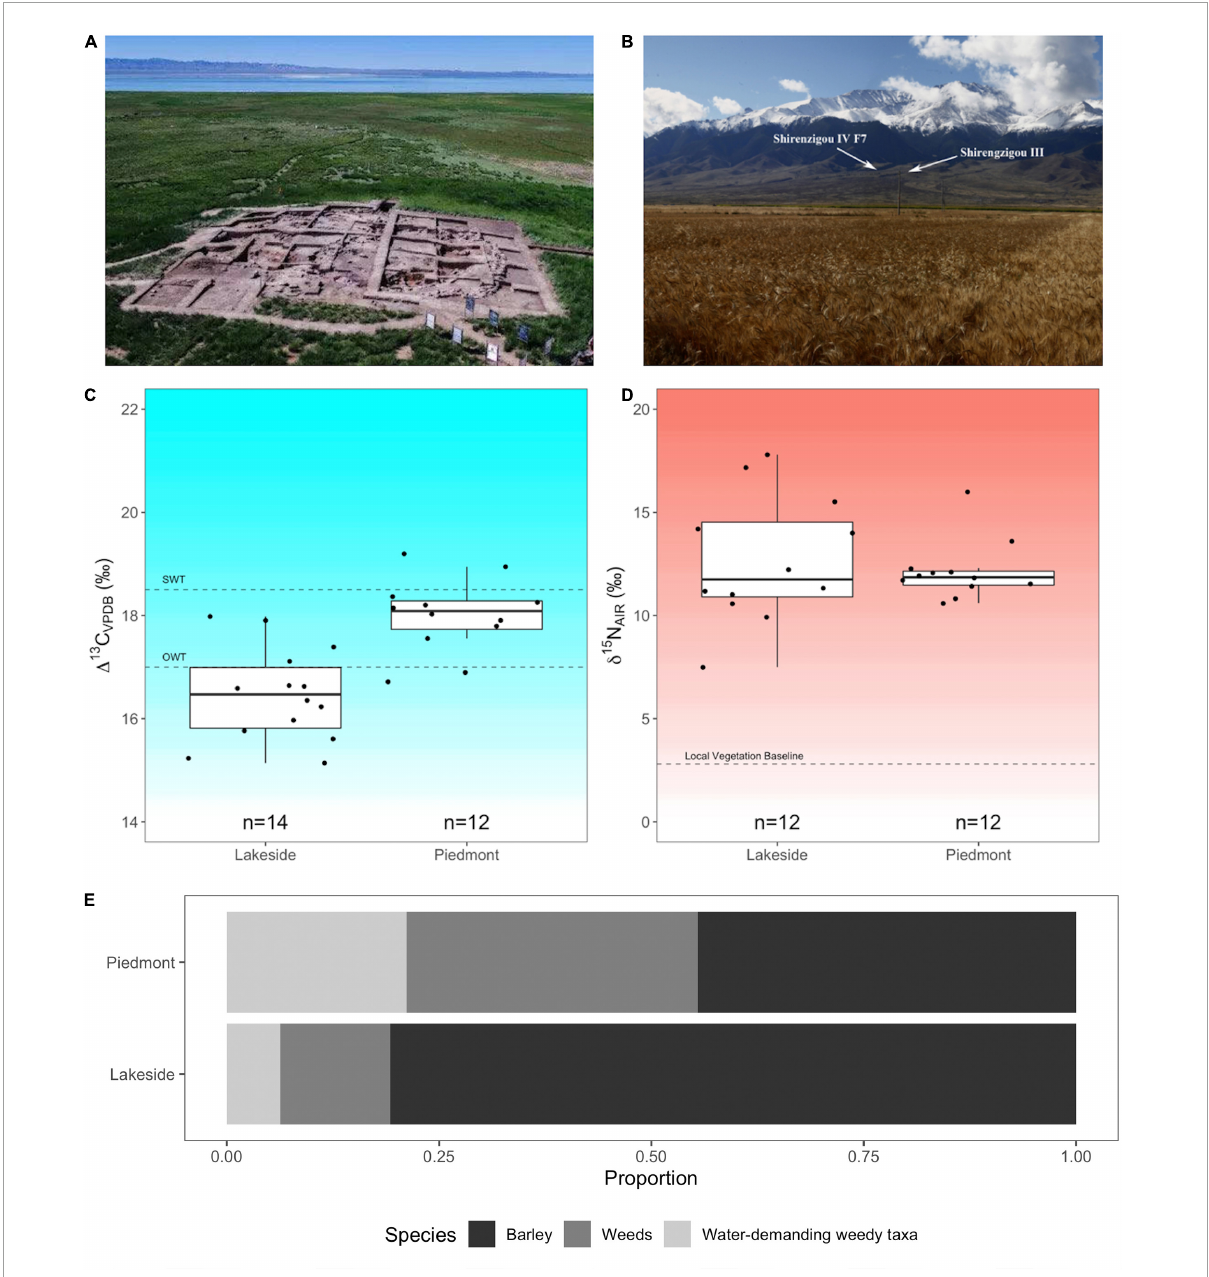
FIGURE6 (A) The typical landscapes of Bronze Age lakeside sites (the excavation area of Haiziyan in 2017) and (B) piedmont sites (the piedmont landscape of Shirenzigou) in the eastern Tianshan region; (C) (cid:49) 13 C and (D) δ 15 N values of archaeological barley from lakeside (Haiziyan, Yanchigucheng) and piedmont sites (Shirenzigou IV, Hongshankou, Kuola); (E) proportion of barley, arable weeds (excluding water-demanding weeds) and water-demanding weeds uncovered from lakeside and piedmont